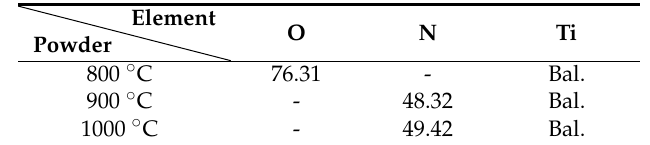
Table 2. Results of energy-dispersive spectrometer (EDS) analysis of the TiO 2 powders nitrided at different temperatures.